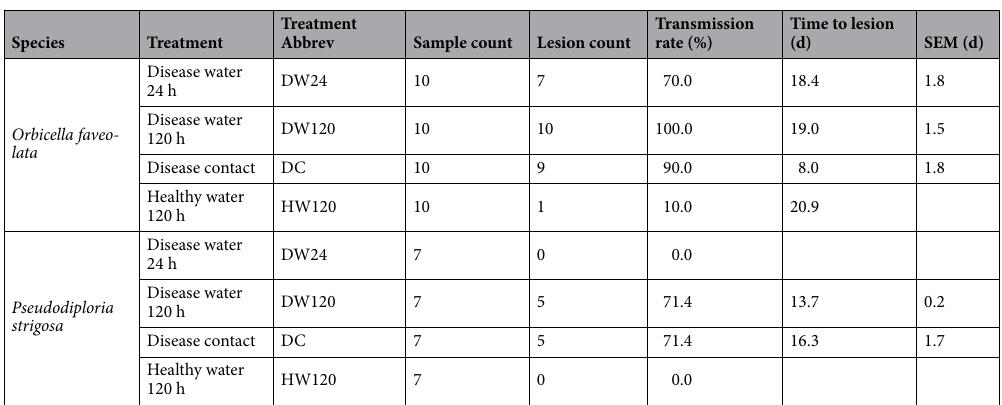
Table 2. Ballast experiment transmission metrics. Transmission rates (proportion of individuals exhibiting SCTLD lesions) and mean ± SEM time to onset of lesions.